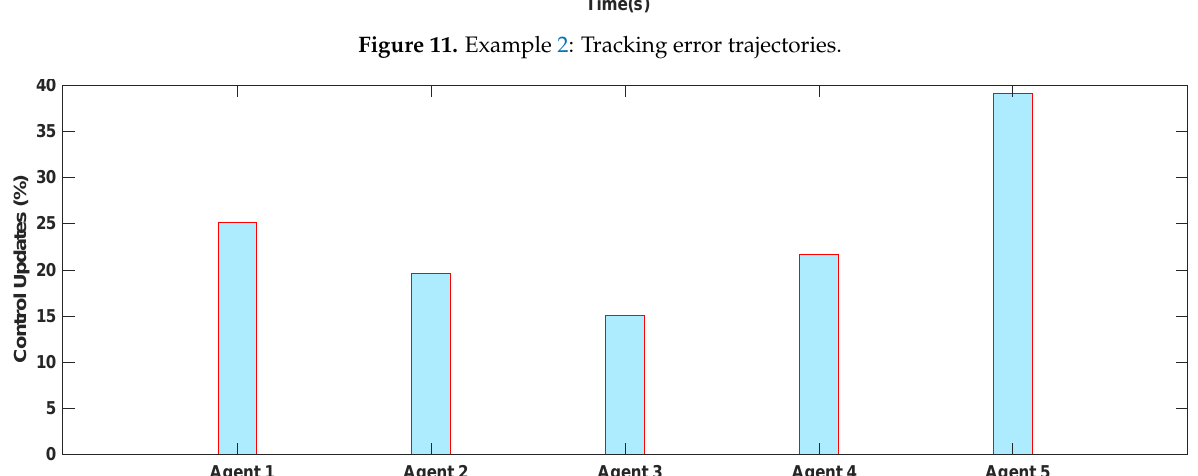
Figure 11. Example 2: Tracking error trajectories.